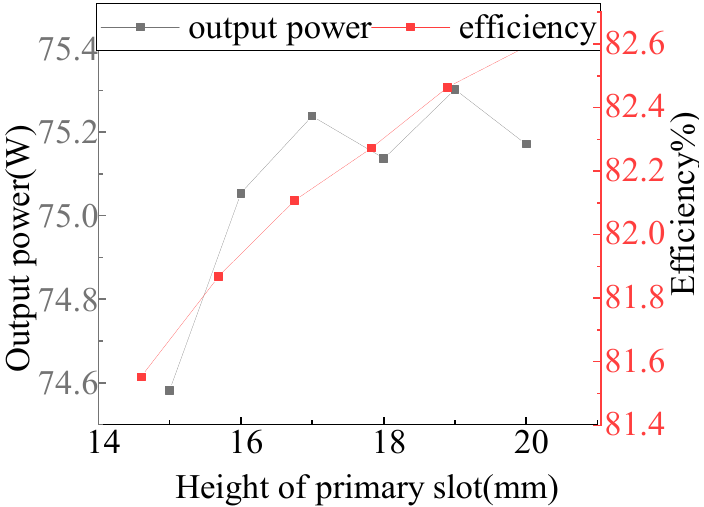
Figure 15. Relationship between electromagnetic force pulsation coefficients and the height of primary slot opening.